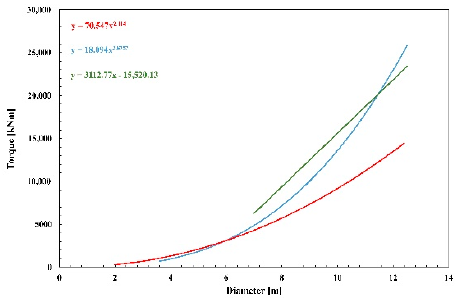
Figure 26. Trend of the torque vs. the diameter based on data collected from the analysis of double shield TBMs. In red, the experimental model proposed in this study; in blue, the model proposed by [42] and in green, the model proposed by [43].